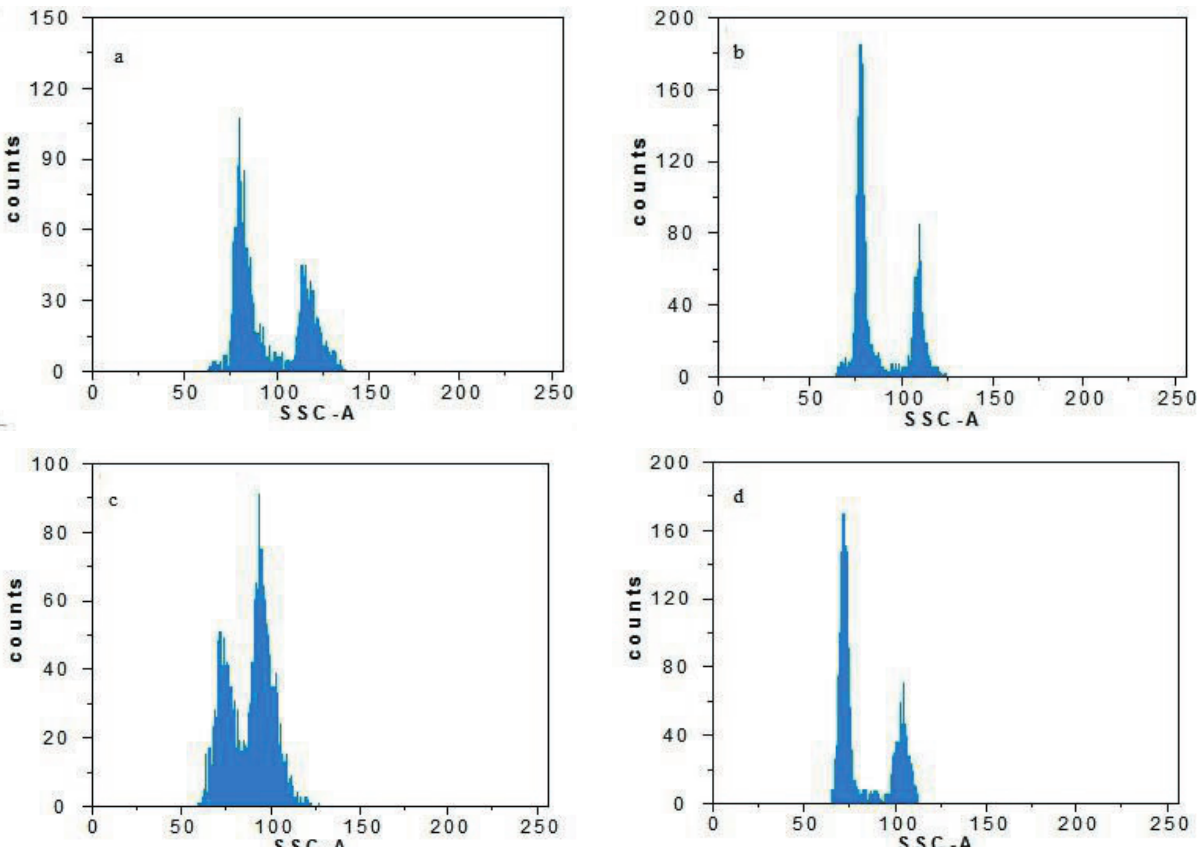
Figure 4. The histogram for analysis of theamount of nuclear DNA in leaves: The left peaks refer to the known parsley ( P. crispum ) refer- ence standard and right peaks to the unknown Hedera samples. a: H. hibernica = 6.23 pg, b: H. hibernica “Deltoiedea” = 6.33 pg, c: H. hiber- nica “Variegata” =5.76 pg , d: H. hibernica “Hamilton” =6.40